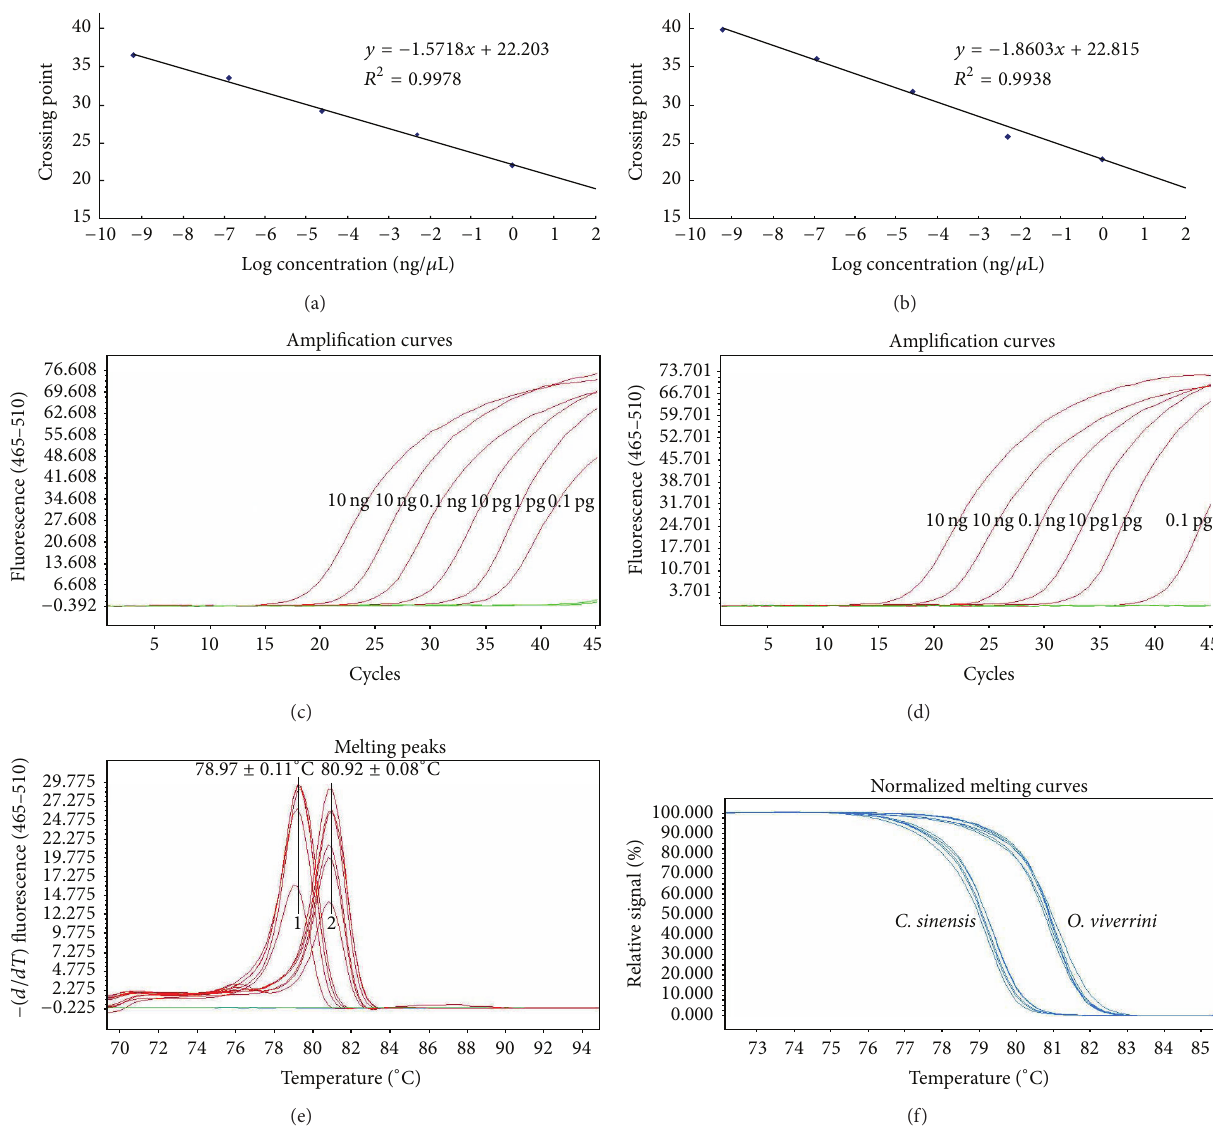
Figure 2: Real-time PCR and HRM analysis of serial diluted genomic DNA. (a) A linear regression of the data providing a formula of 𝑦 = −1.8603 log (𝑥) + 22.815 (𝑅 2 = 0.9978) , template dilutions 10 ng/ 𝜇 L to 1pg/ 𝜇 L of C. sinensis . (b) A linear regression of the data providing a formula of 𝑦 = −1.5718 log (𝑥) + 22.203 (𝑅 2 = 0.9938) , template dilutions 10ng/ 𝜇 L to 1pg/ 𝜇 L of O. viverrini . (c) Amplification curves of diluted genomic DNA of C. sinensis; 1–6: dilutions 10ng/ 𝜇 L to 1pg/ 𝜇 L. (d) Amplification curves of diluted genomic DNA of O. viverrini ; 1–6: dilutions 10 ng/ 𝜇 L to 1pg/ 𝜇 L. (e) Melting peaks of amplicon of diluted genomic DNA from two liver flukes (10ng/ 𝜇 L to 1pg/ 𝜇 L); 1: C. sinensis , 78.97 ± 0.11 ∘ C; 2: O. viverrini , 80.92 ± 0.08 ∘ C. (f) Normalized melting curves of diluted genomic DNA from two liver flukes (10ng/ 𝜇 L to 1pg/ 𝜇